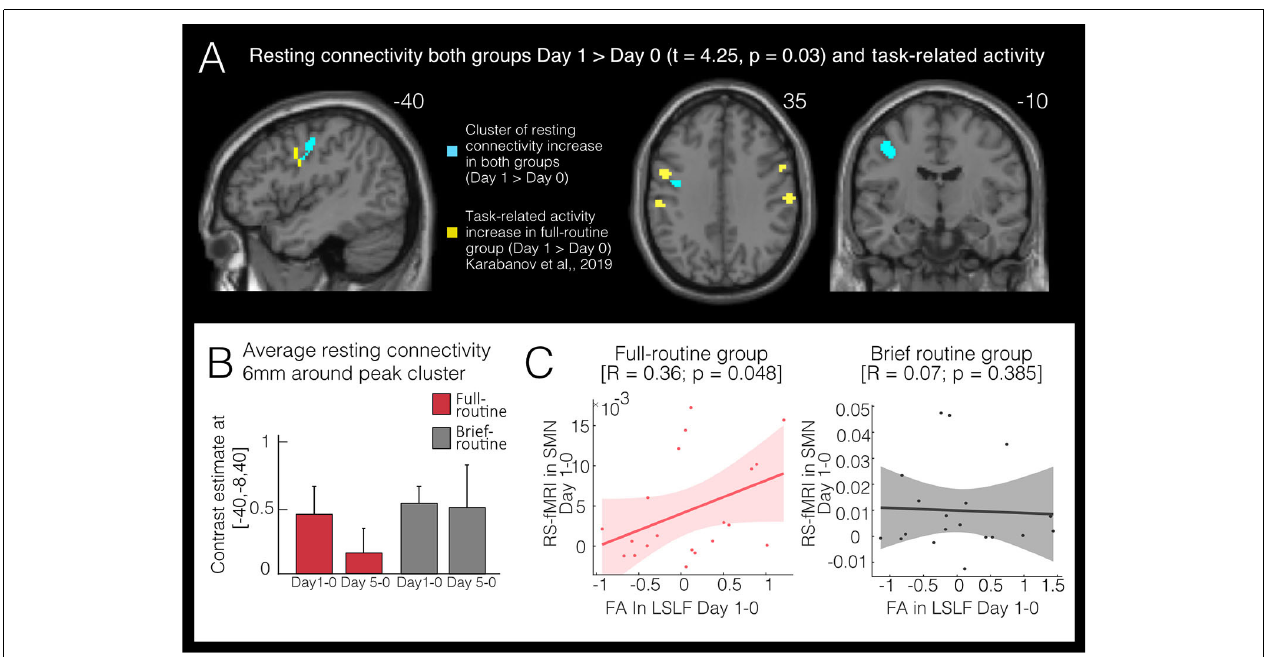
FIGURE 3 | Functional changes following bimanual skill learning. (A) Resting-state sensorimotor connectivity increases in both full-routine and brief-routine group in a left premotor cluster after one day of in-scanner training (Day 1 > Day 0). Significant clusters of change in task-related fMRI (yellow; Karabanov et al., 2019) lie in close spatial proximity to the resting-state clusters (blue). (B) Average resting-state (rs-)connectivity in both groups in significant clusters (Day 1 > Day 0) within a 6 mm sphere around peak voxel ( − 40, − 8, 40). Both groups show increased rs-connectivity on Day 1 compared to baseline but only the full-routine group showed a correlation (C) between the increase in functional rs-connectivity and the decrease in FA ( r = 0.36, p corr = 0.05). Also, only the full-routine group showed a tendency of rs-connectivity lowering back to baseline levels at the last scanning